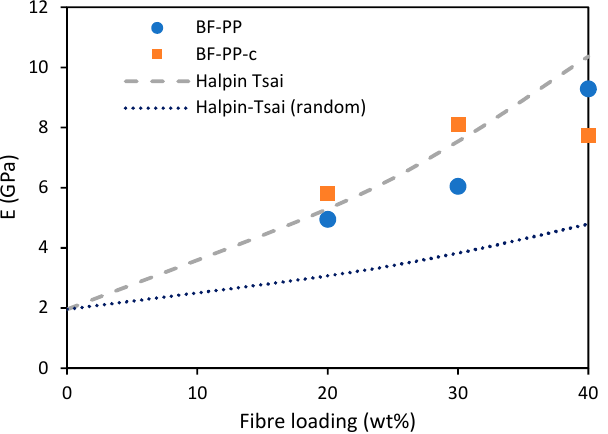
Figure 10. Predicted and measured Young’s moduli of short BF-PP composites.